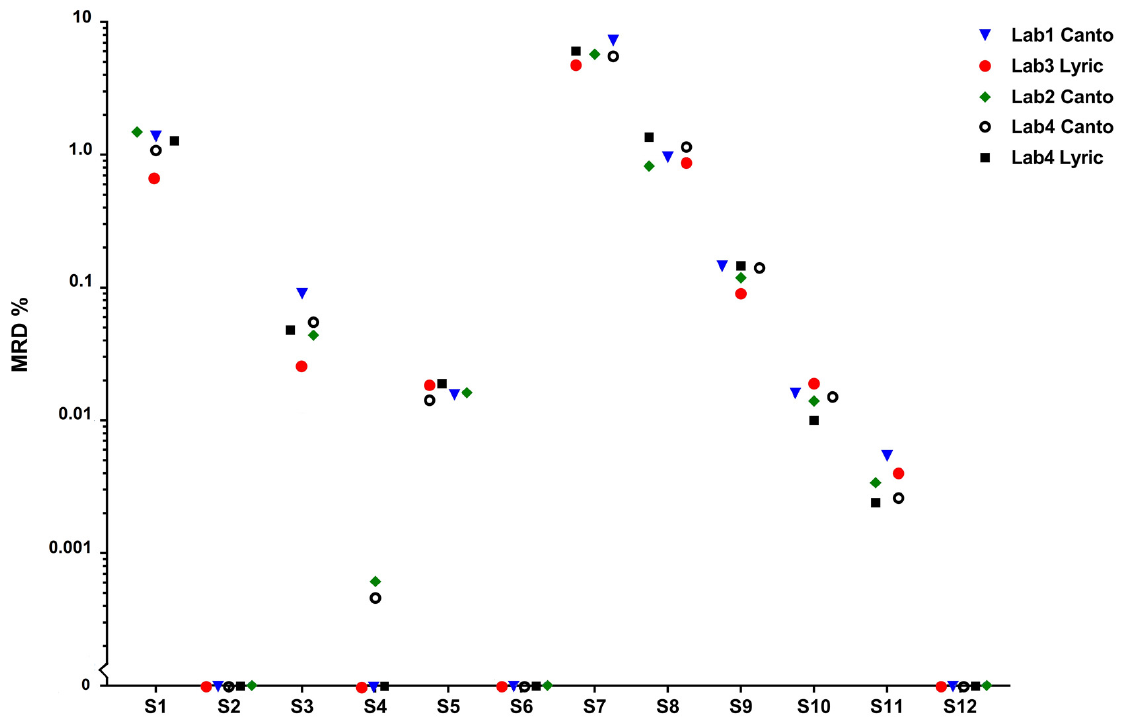
Figure 1. Results of MRD assessment in inter-laboratory comparability study. Samples 2, 6 and 12 did not contain pathological plasma cells.